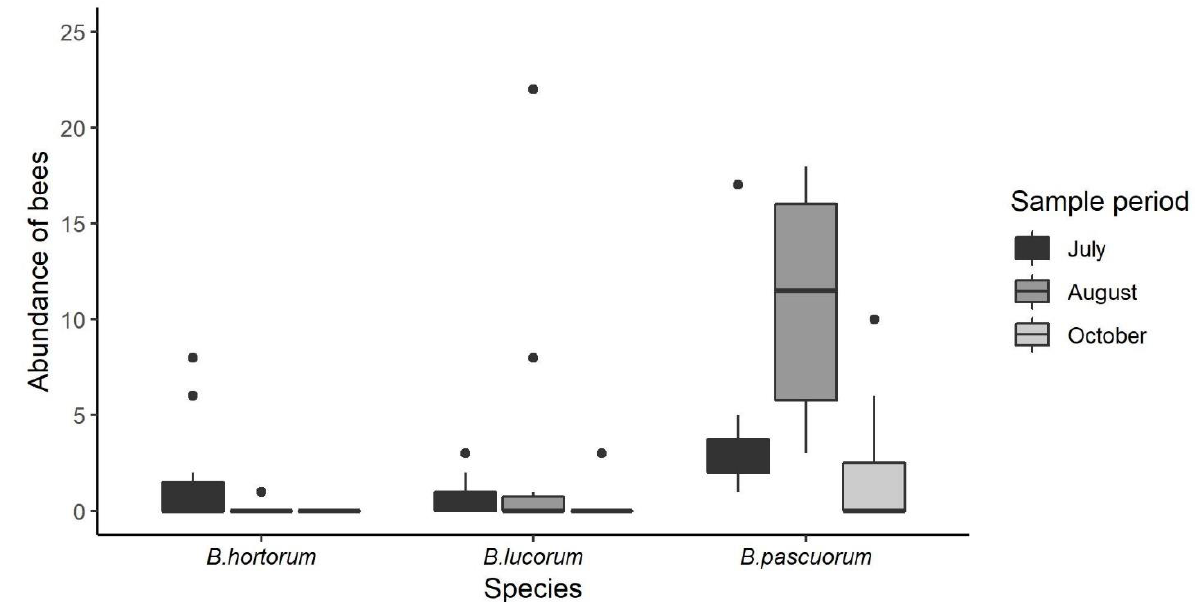
Figure 3. Boxplot showing the abundance of bumblebees observed visiting F. magellanica per site in each sampling period. Bombus jonellus and Bombus pratorum were also observed once each in the Sligo site in August, but were not included in further analyses.